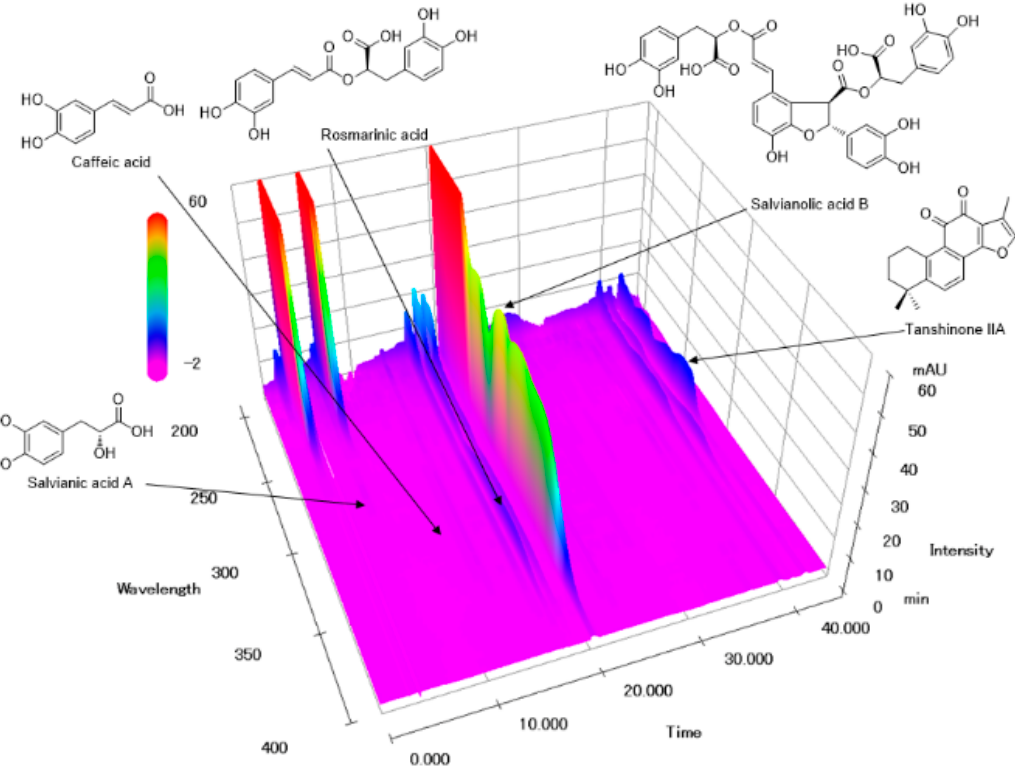
Figure 1. Three-dimensional high-performance liquid chromatogram of 70% ethanol extract of Salviae Figure 1. Three ‐ dimensional high ‐ performance liquid chromatogram of 70% ethanol extract of Salviae miltiorrhizae Miltiorrhizae Radix.